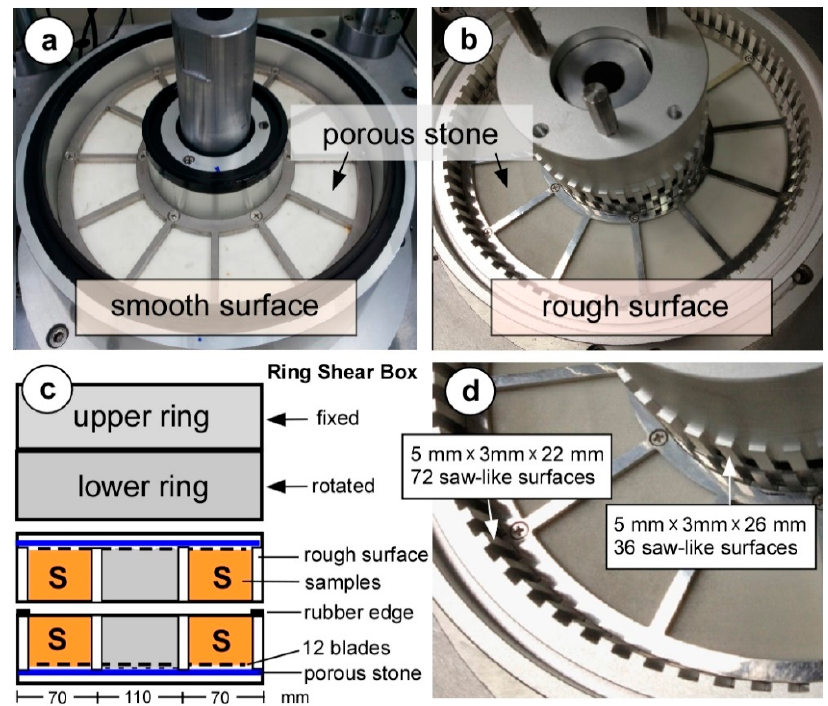
Figure 2. Ring shear box: ( a ) Smooth surface; ( b ) rough surfaces; ( c ) schematic view; and ( d ) inside view with inner and outer rough surfaces.